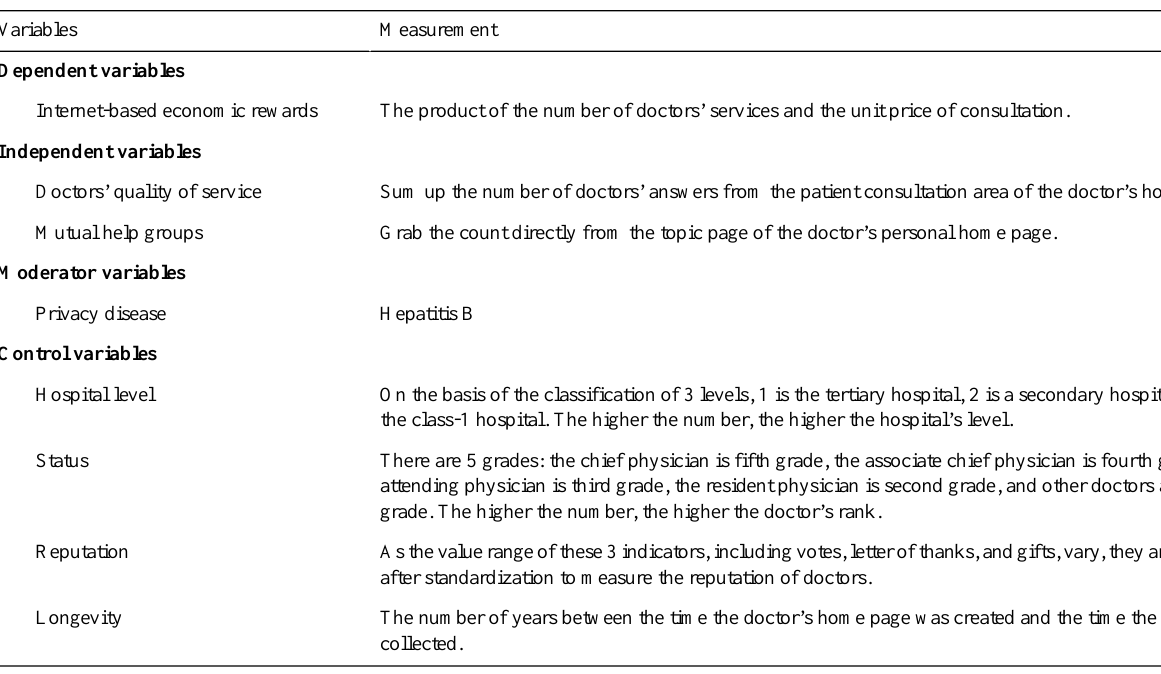
Table 1. Measurement of variables.